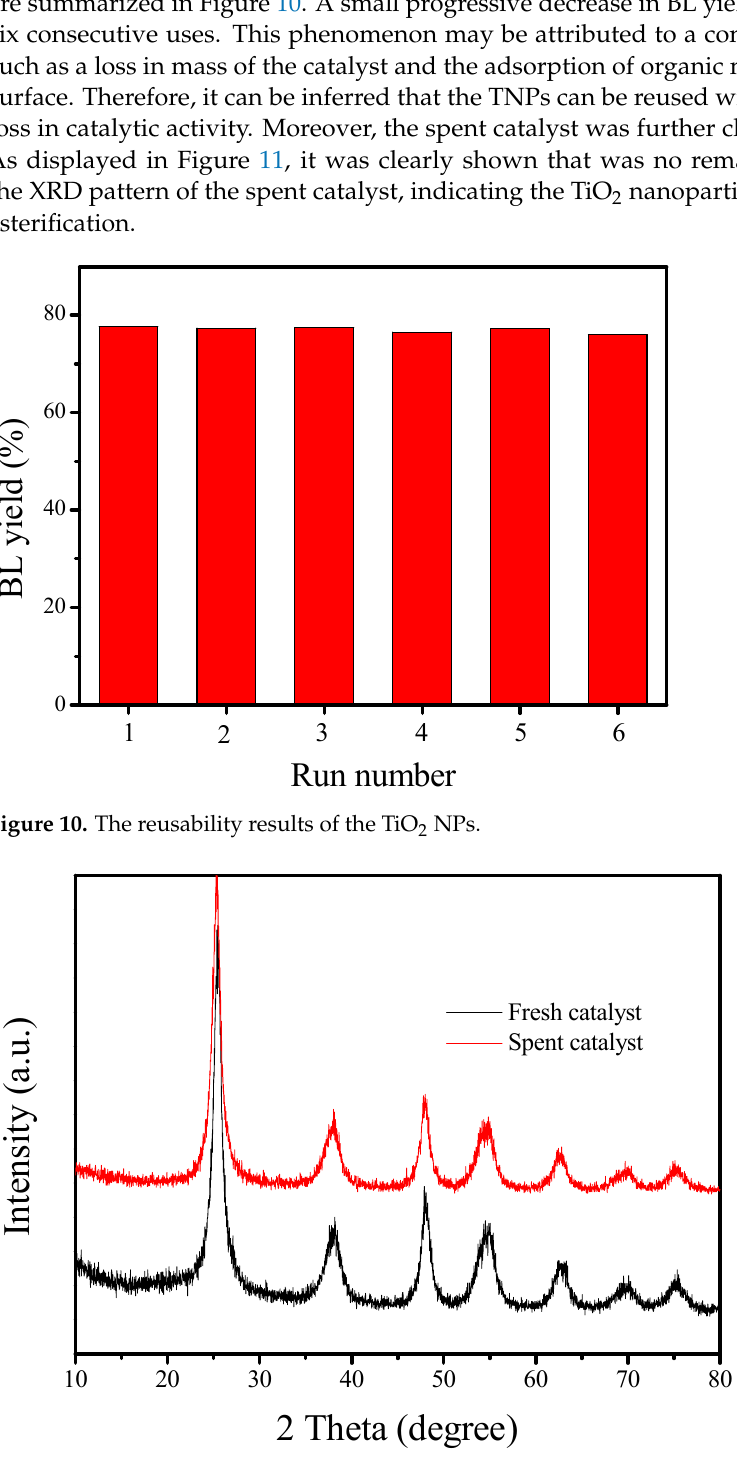
Figure 11. XRD pattern of the spent TNPs catalyst.